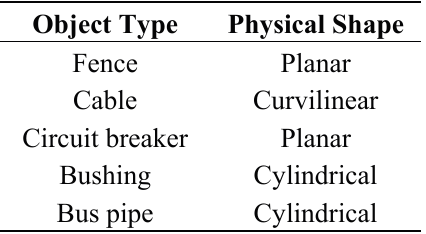
Table 1. Physical shape of electrical substations key